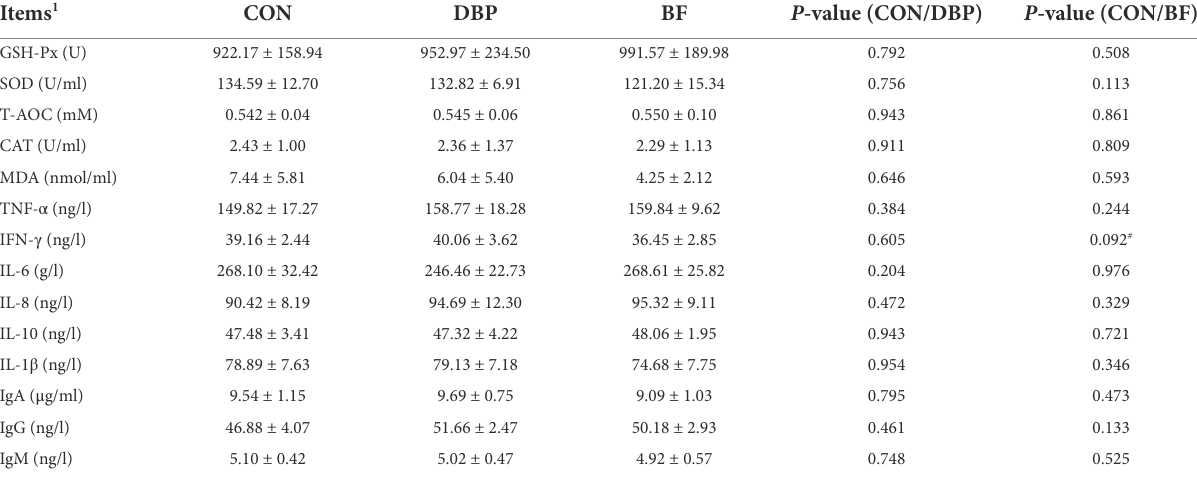
TABLE 3 Effects of DBP and BF on serum biochemical parameters in